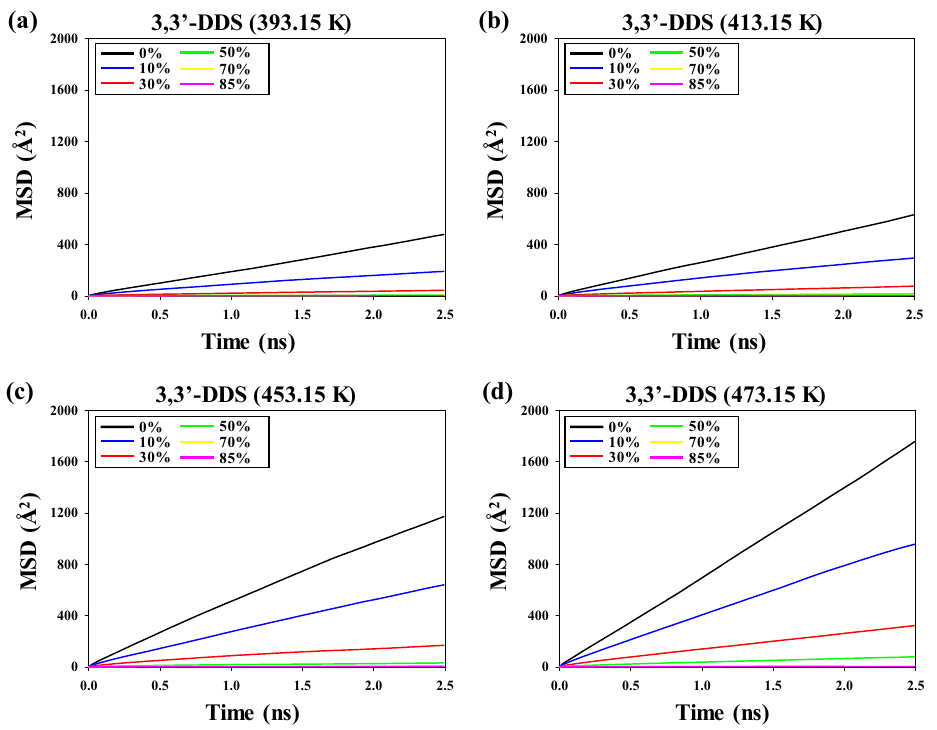
Figure 2. Mean squared displacement (MSD) of 3,3 ′ -DDS at ( a ) 393.15 K, ( b ) 413.15 K, ( c ) 453.15 K, and ( d ) 473.15